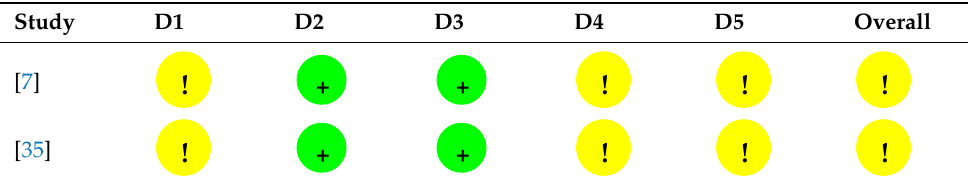
Table 4. Assessment of the risk in randomized studies included with RoB 2.